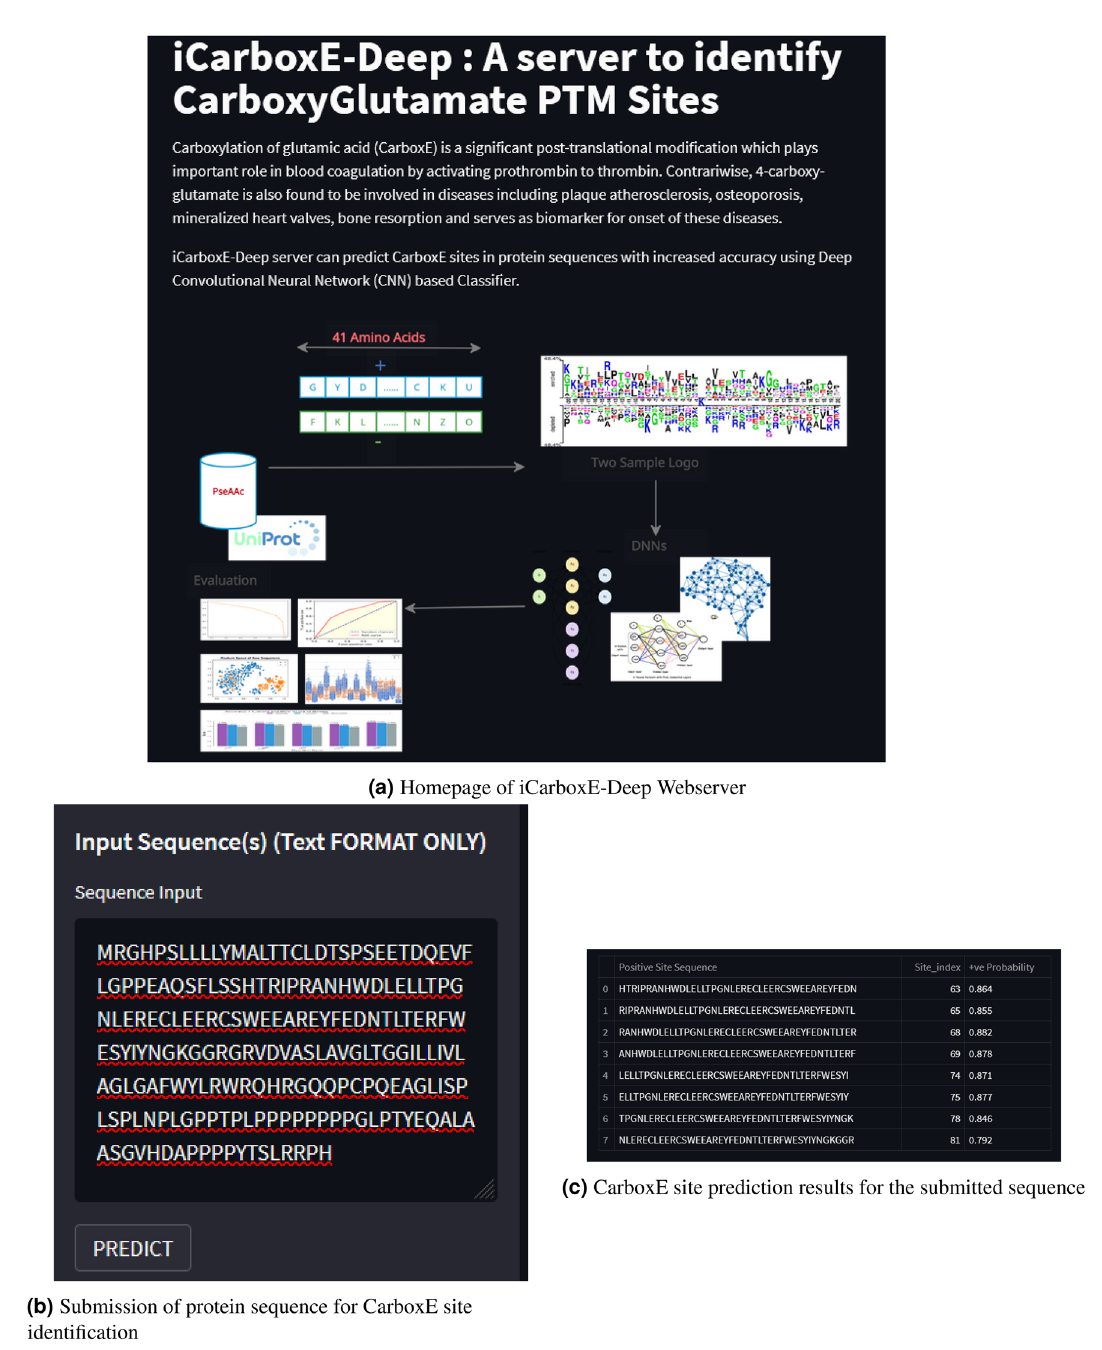
Figure 5. iCarboxE-Deep Webserver functionalities for identification of